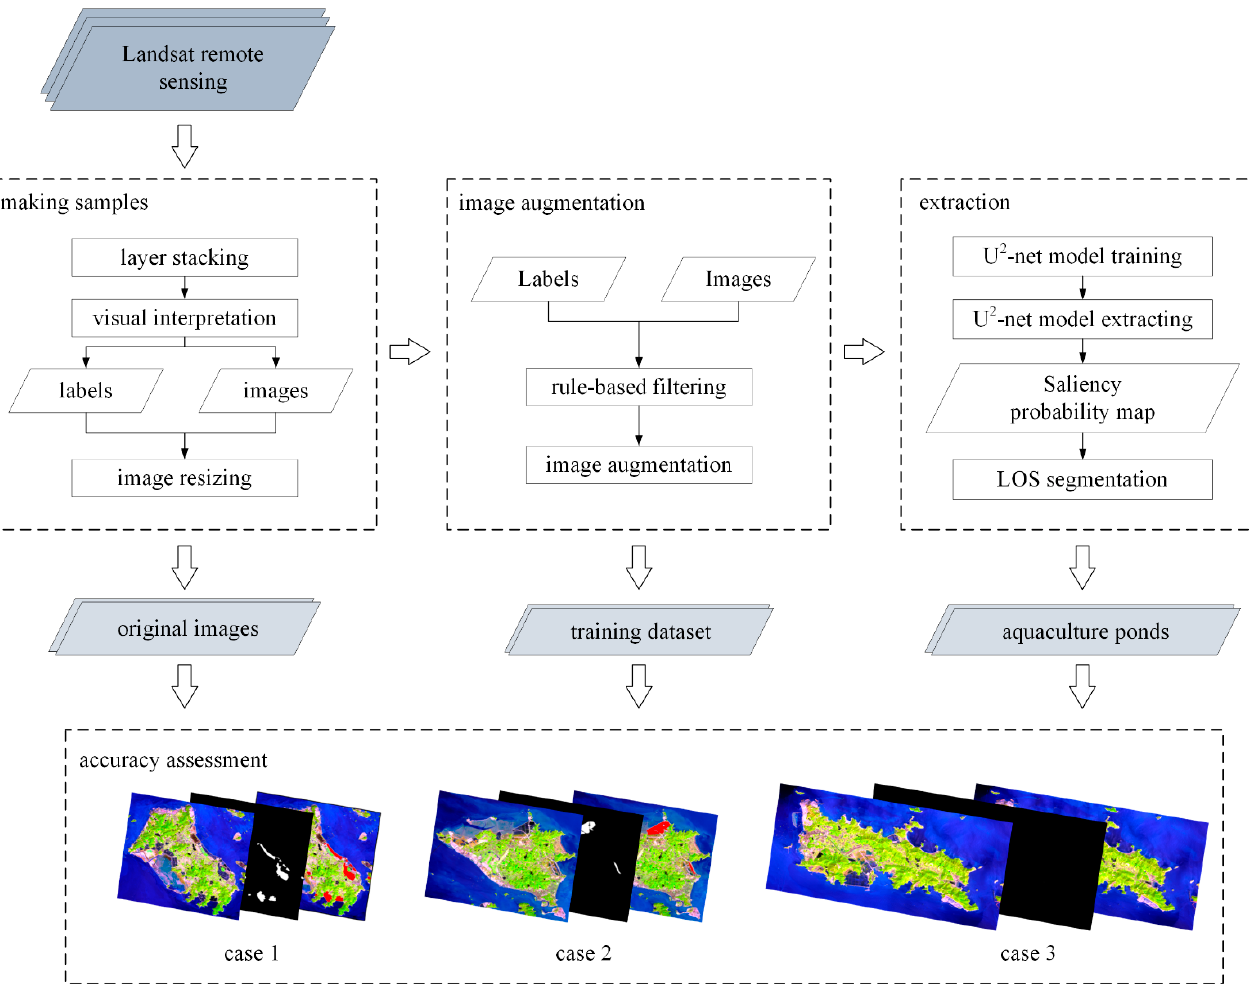
Figure 2. The workflow of the study.